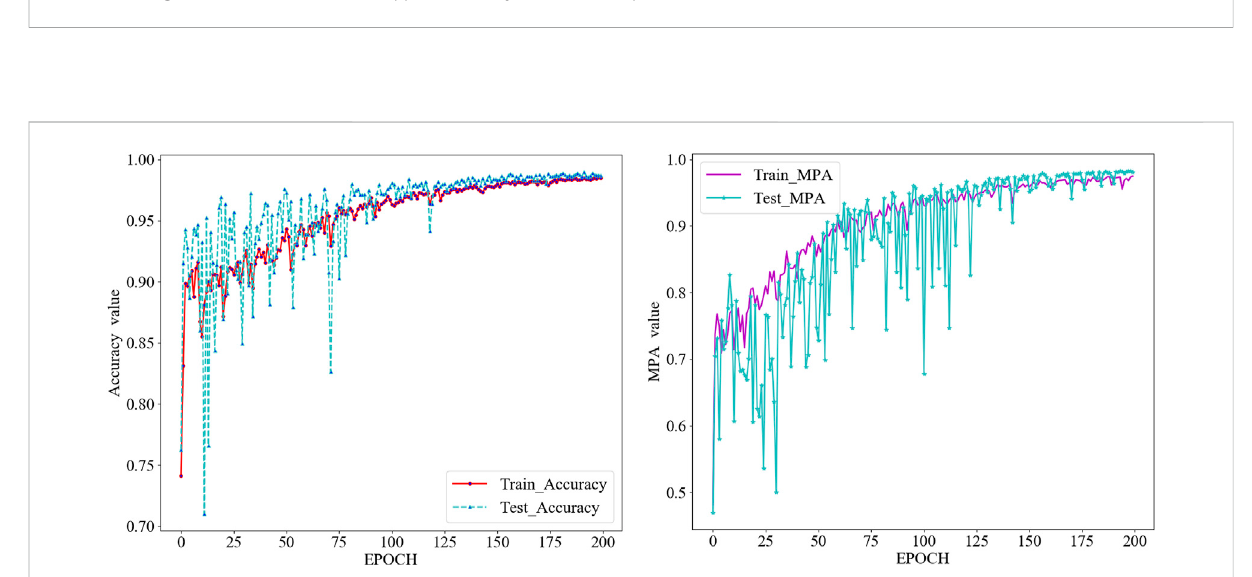
FIGURE 13 Model training without land surface re fl ectance support accuracy and MPA vs.